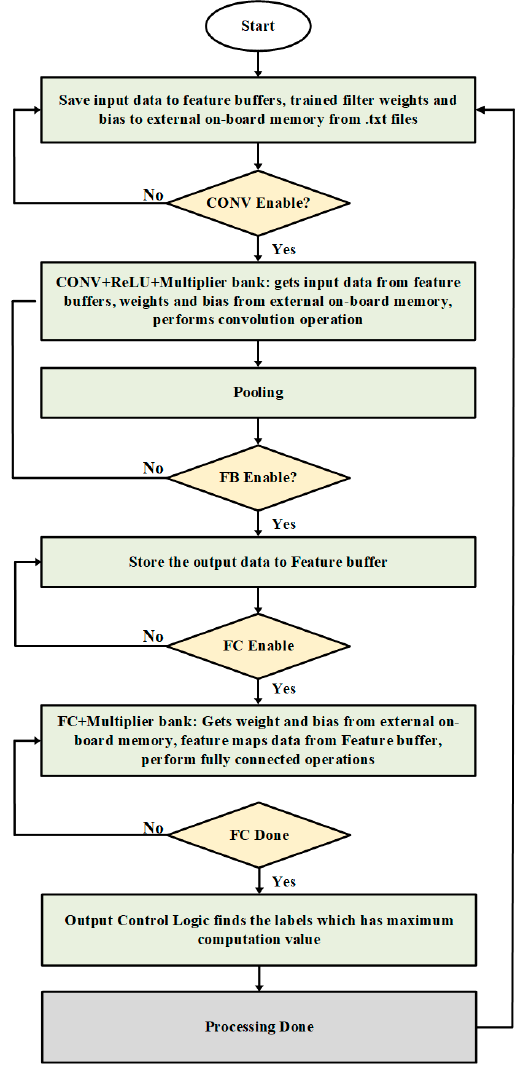
Figure 2. Flow chart of the proposed CNN architecture.